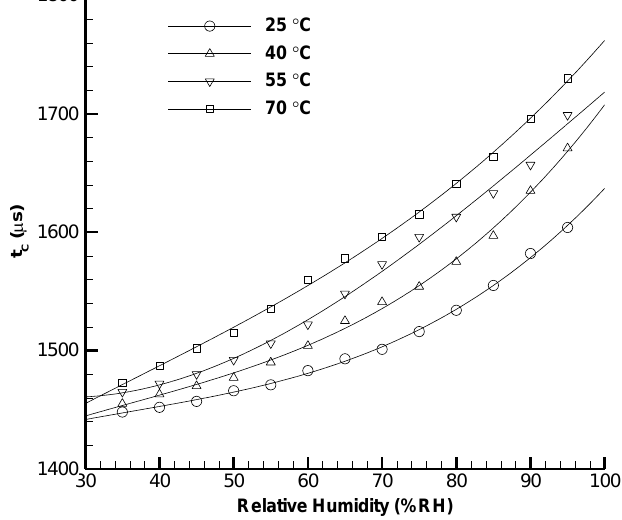
Figure 6. Calibration of wireless integration for humidity sensor at different temperatures (25, 40, 55, 70 °C) in environmental